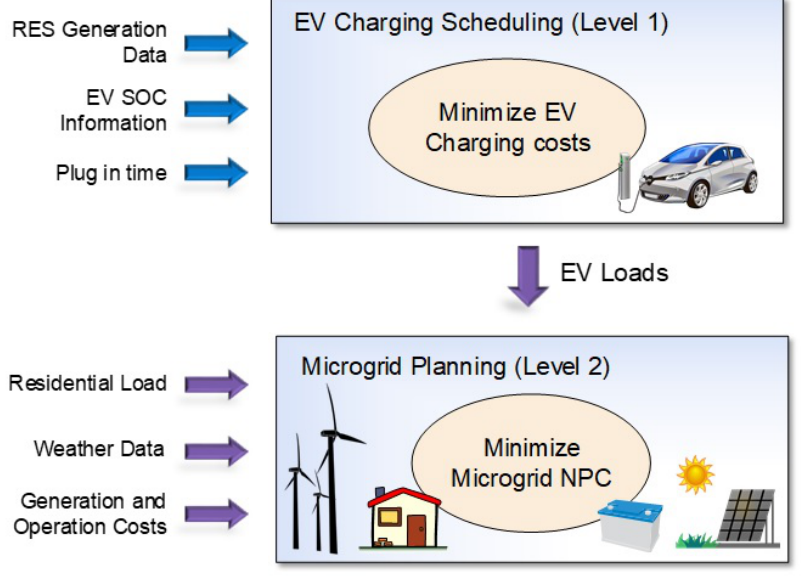
Figure 1. Proposed microgrid planning